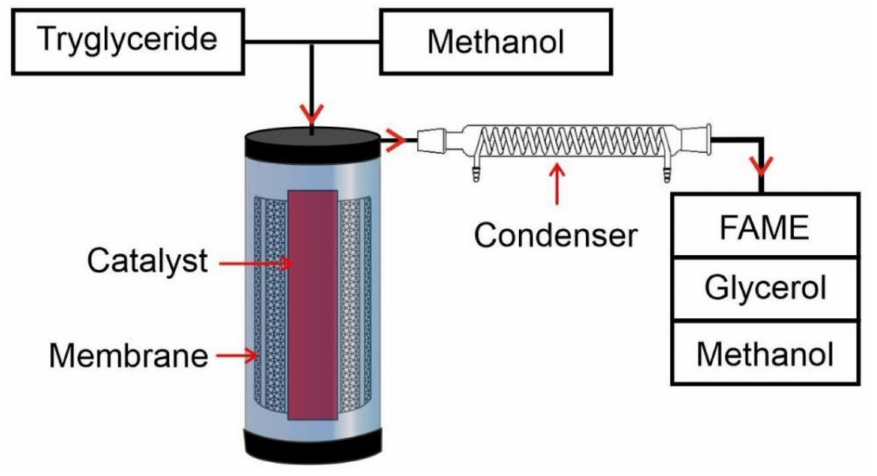
Figure 5. Schematic of packed bed membrane